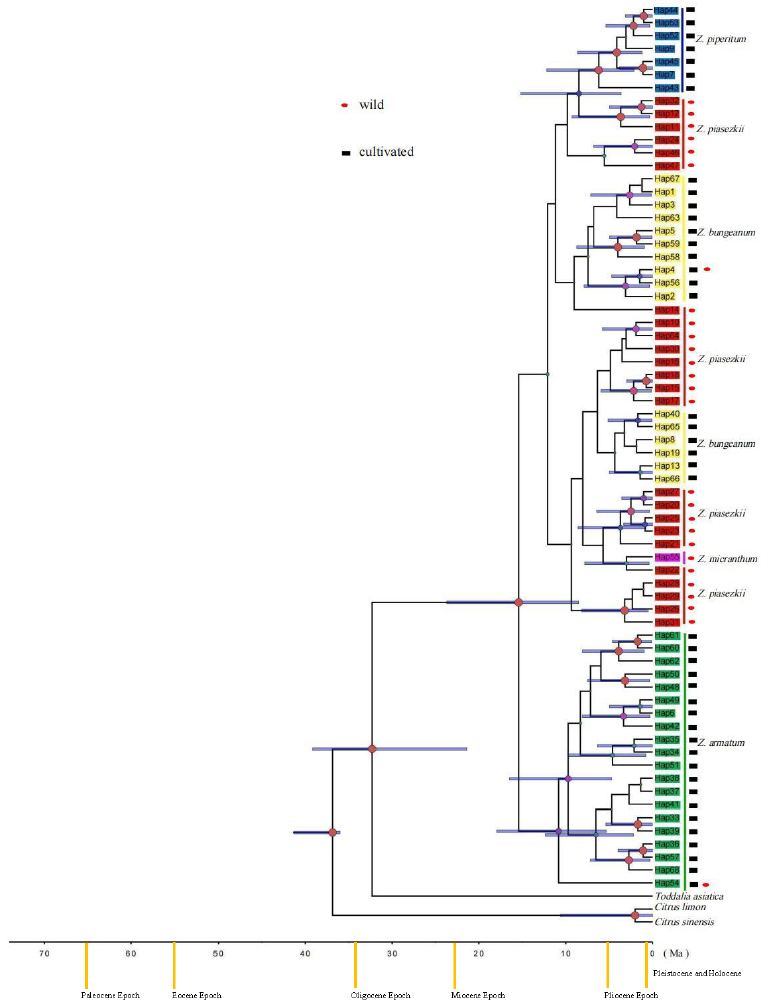
Figure 4. The maximum clade credibility tree (MCC) was generated based on the dataset of 68. cpDNA haplotypes of 373 Zanthoxylum accessions. Taddalia asiatica , Citrus limon , and Citrus sinensis were used as outgroups. Posterior probabilities based on maximum-likelihood (ML) analysis are labeled above nodes. Blue bars represent the 95% highest posterior density (HPD) credibility intervals for node ages (in Myr ago, Ma).